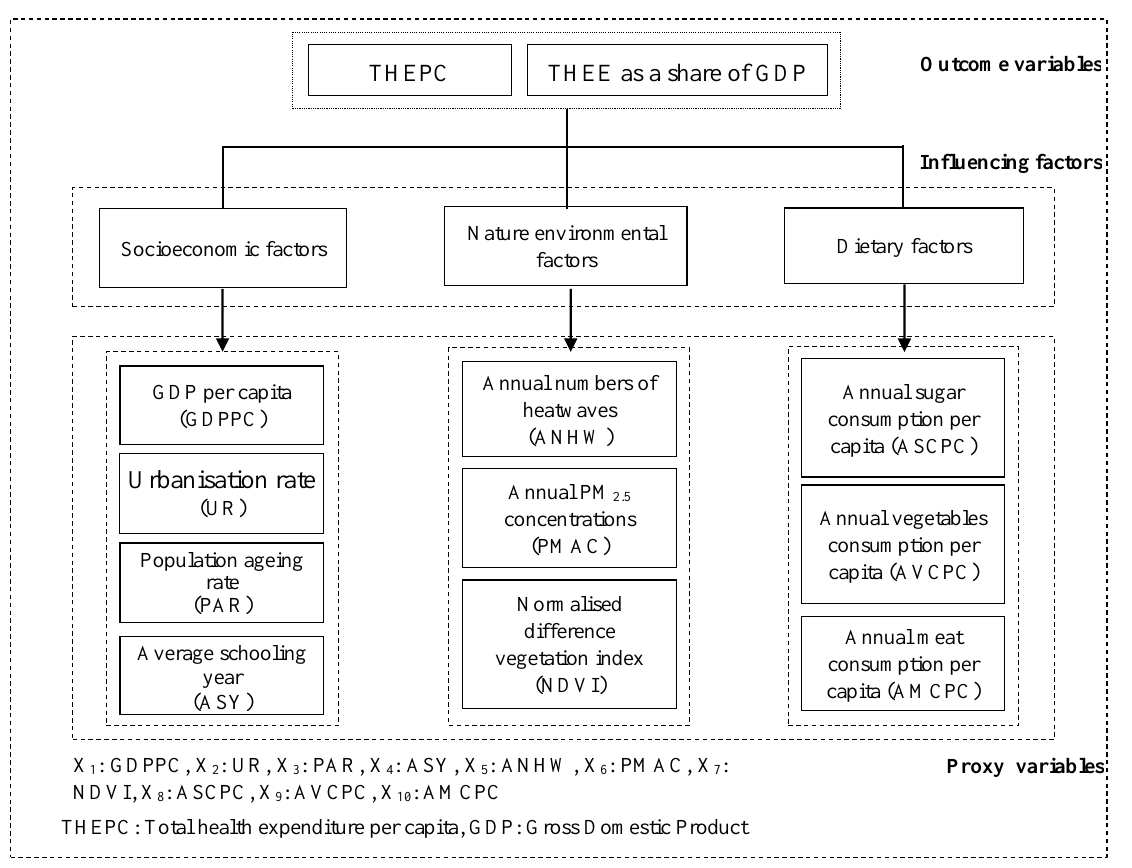
Figure 2. Relationships between outcome variables, the THEPC and the THEE’s share of the GDP, and three categories of influencing variables containing 10 proxy variables.